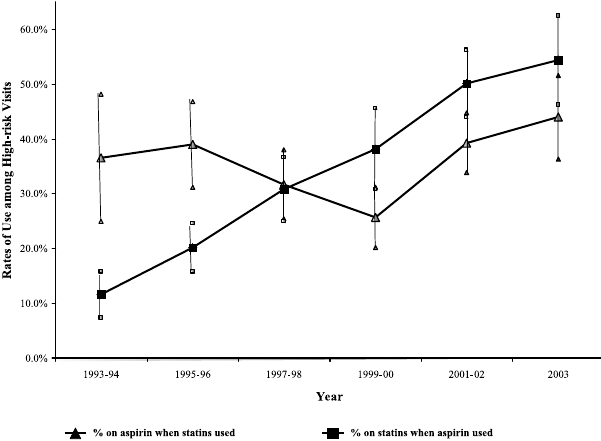
Figure 3. National Trends in Aspirin and Statin Use When the Other Therapy Is Present among Intermediate-Risk Patient Visits Vertical bars indicate 99% CIs. DOI: